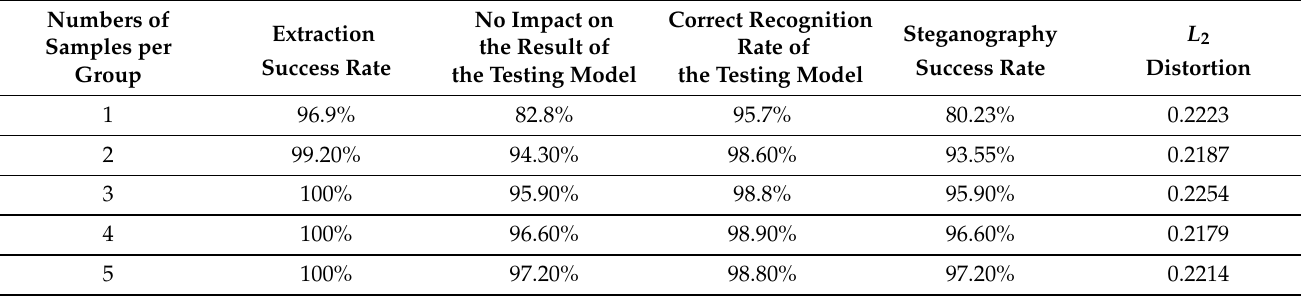
Table 3. Statistics of the variation of steganographic success rate, correct recognition rate of the testing model, probability of no impact on the testing model, correct information extraction rate, and L 2 distortion with different number of samples per group.